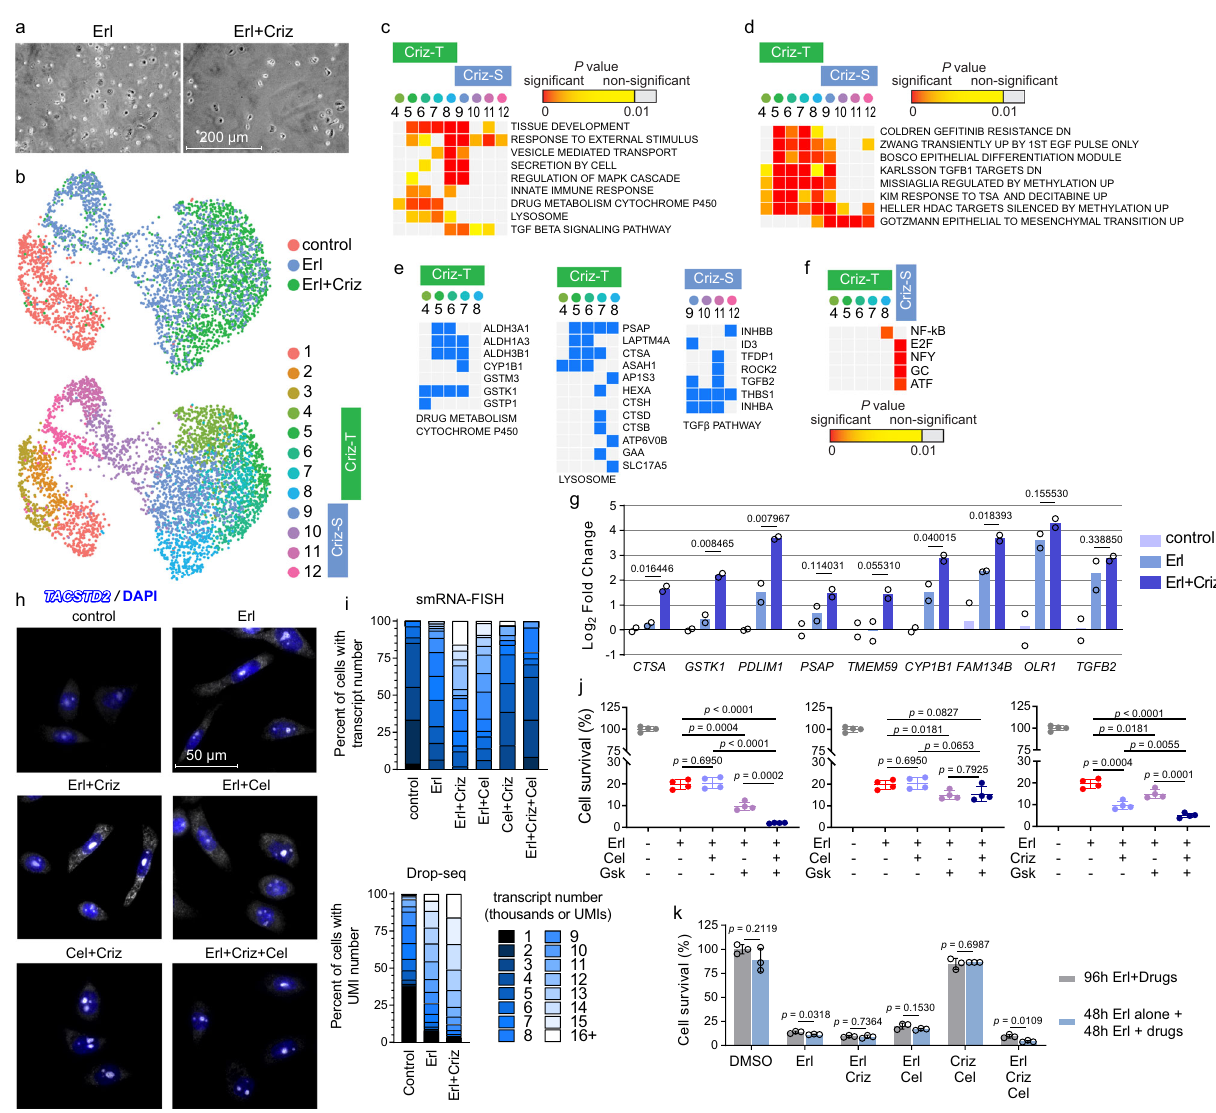
Fig. 6 Crizotinib-tolerant cells represent a subpopulation of erlotinib-tolerant cells. a , b PC9 cells were treated for 3 days with 2 µ M erlotinib (Erl), with 1 µ M erlotinib and 1 µ M crizotinib (Erl + Criz) or left untreated (control). a Representative microscopic images of the cells. The experiment was repeated six times independently with similar results. b UMAP representation of PC9 cells colored by treatment and by crizotinib-tolerant (Criz-T) and crizotinib- sensitive (Criz-S) clusters. n = 2 biological replicates. c Enrichment analysis for gene relations to GO BP and KEGG pathways terms is shown for top DT cluster markers ( P < 0.05). d Enrichment analysis for gene sets associated with CGPs. Gene sets with P < 10 − 7 and >11 markers in a DT cluster but P > 10 − 4 in any untreated cluster are shown. e Criz-T and Criz-S markers in top enriched terms. f Occurrences of TF-binding sites (TFBSs) from TRANSFAC database in promoters of Criz-T cluster markers and combined Criz-S markers. Enriched TFBSs with corrected P < 10 − 9 are shown in the heatmap. In c , d and f , data represents right tail P values, two-sided binomial statistical test, adjusted for multiple testing using Benjamini – Hochberg FDR method. g Gene expression changes in the levels of Criz-S and Criz-T markers using bulk RNA samples. The RT-qPCR data was normalized to POLR2B level and presented as Log 2 fold change relative to DMSO-treated control cells, mean for n = 2 biological replicates. h smRNA-FISH reveals high TACSTD2 expression as a characteristic of Erl + Criz-tolerant cells, which is abrogated by celastrol. The experiment was repeated two times independently with similar results. i Quantitation of fl uorescent microscopy images (at the top) and Drop-seq data (at the bottom) showing TACSTD2 transcript abundance. Scaled average expression across cells is shown by the color of the bar, with a darker blue representing a low expression, and white representing a high expression. j Survival assays of PC9 cells treated for 11 days with the drugs as in Fig. 5f. Data represents mean ± SD for n = 4 replicate wells. k Survival assays of PC9 cells subjected to successive drug treatment. Data represents mean ± SD ( n = 3). In j and k , two-tailed P values were determined by unpaired t test relative to the simultaneous treatment via GraphPad Prism 7. reports in other tumors (reviewed by Suva and co-authors 47 ), identities of >99% cells to 16 different cell types. We included previously reported data from three donors 46 in our analysis to cancer cells were patient-speci fi c (Fig. 8e). Following the identi fi cation of cancer epithelial cells, we ascertained their compare tumor cells to lung tissue without disease. Non- similarity to other tissues in order to identify the cell of origin. In hematopoietic cells were subset and further clustered, leading to comparison to ciliated, Club/Clara cells, pulmonary alveolar type identi fi cation of nonmalignant and cancer epithelial cells 1 (AT1) and pulmonary alveolar type 2 (AT2) (Fig. 8d), the (Fig. 8c – e and Supplementary Data 26). Consistent with previous NATURE COMMUNICATIONS| (2021) 12:1628